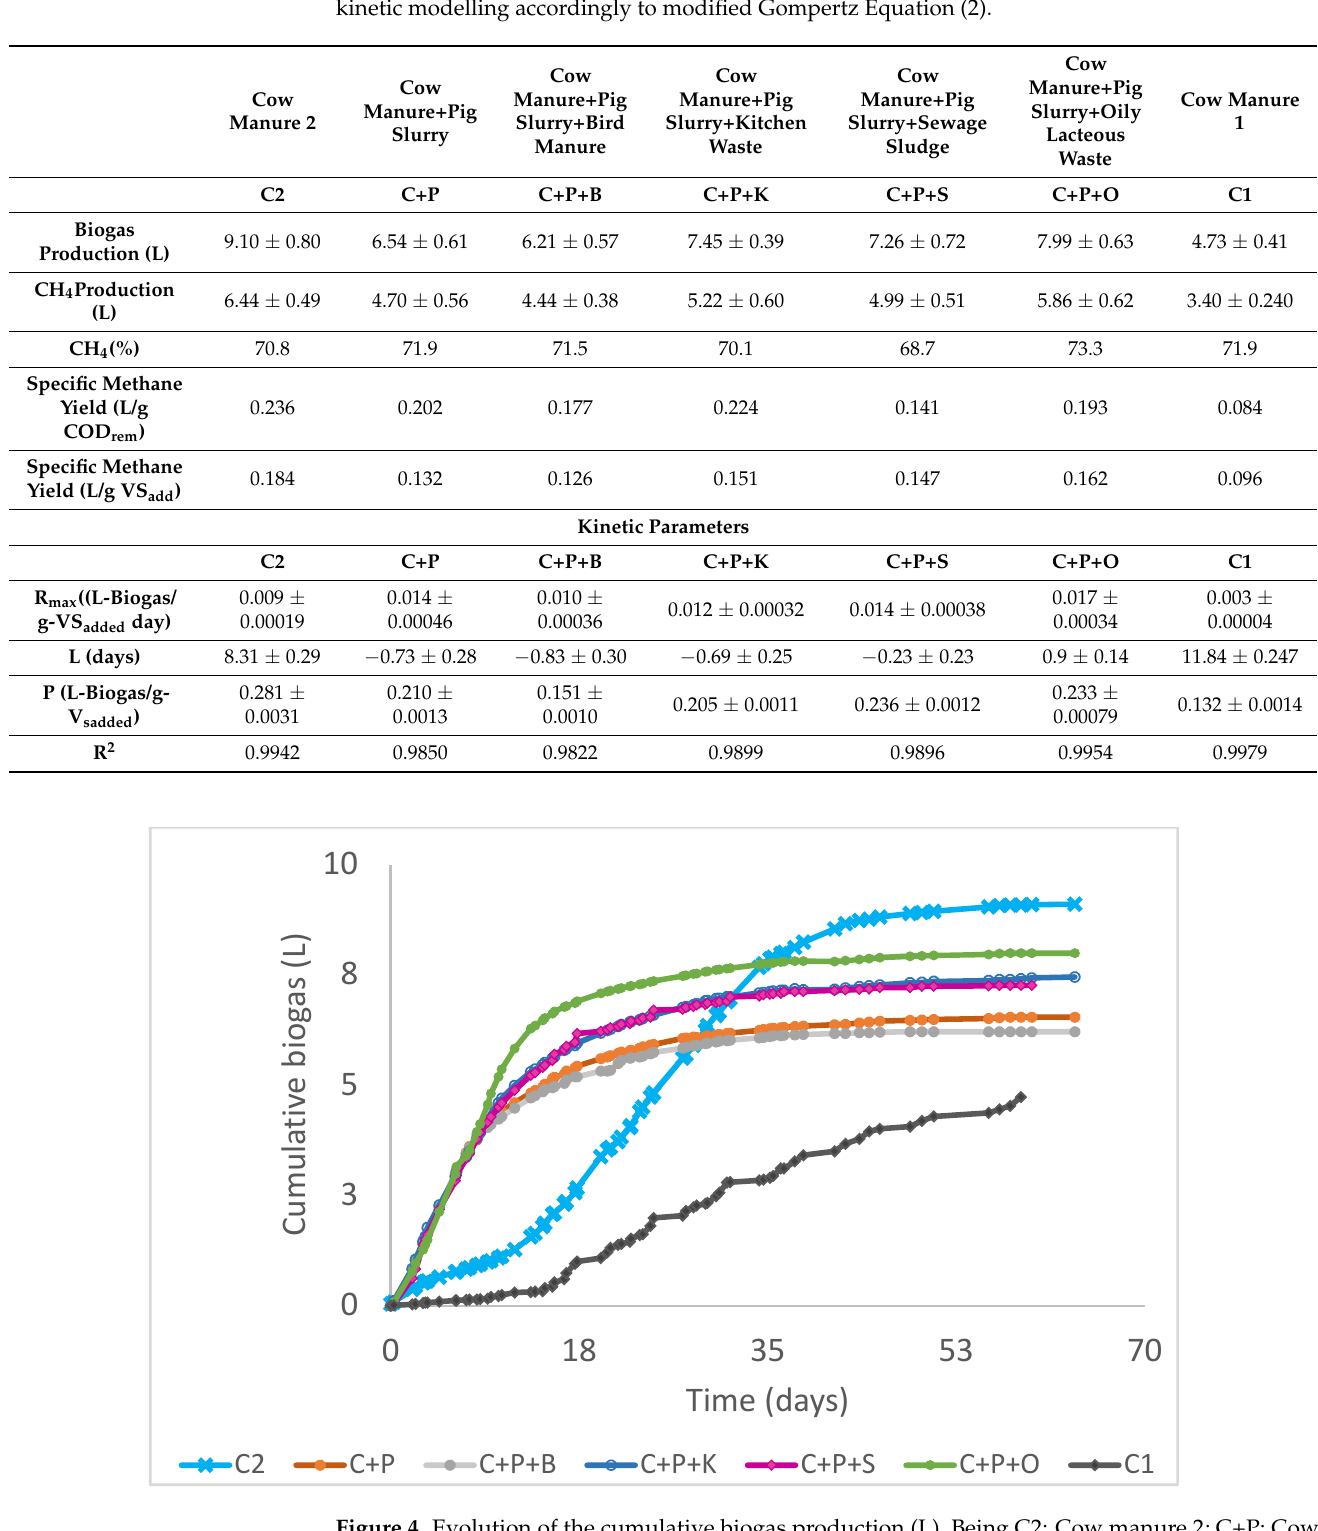
Figure 4. Evolution of the cumulative biogas production (L). Being C2: Cow manure 2; C+P: Cow manure+Pig slurry; C+P+B: Cow manure+Pig slurry+Bird manure; C+P+K: Cow manure +Pig slurry+Kitchen waste; C+P+S: Cow manure+Pig slurry+Sewage sludge; C+P+O: Cow manure+Pig slurry+Oily lacteous waste; C1: Cow manure 1.